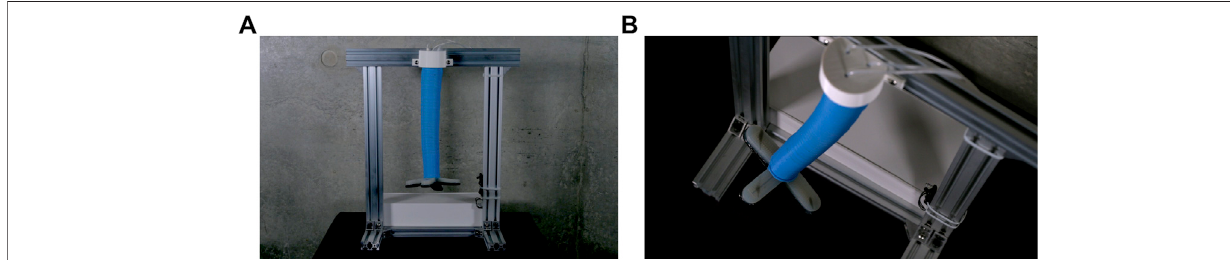
FIGURE 4 | The tentacle robot. Front view (A) and top view (B) .